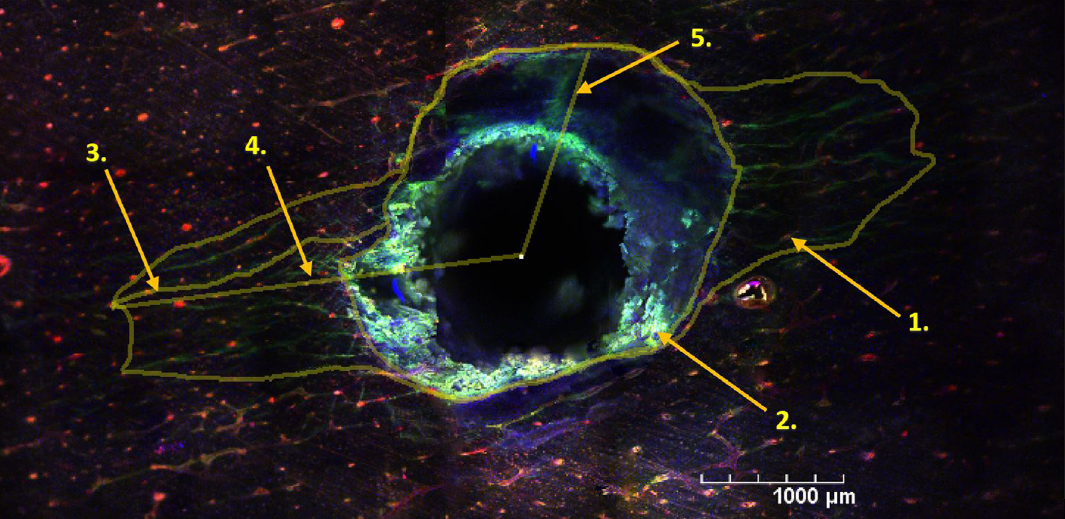
Figure 1. Histomorphometric parameters. (1) Total damaged area. (2) Diffuse area area. (3) Maximum crack length. (4) Maximum damage radius. (5) Maximum diffuse damage radius. Stain colours: Xylenol orange identifies iatrogenic damage, Calcein identifies damage created on screw insertion, Calcein blue identifies damage on screw